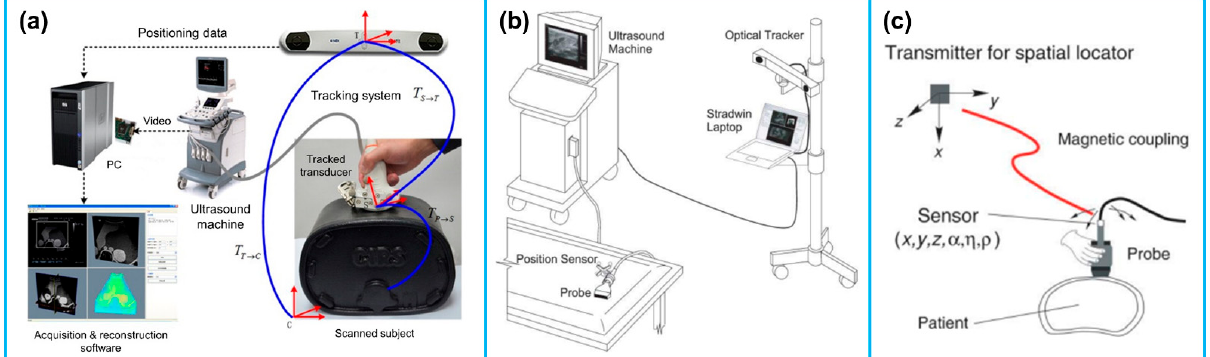
Figure 7. ( a ) The typical configuration of a freehand 3D US imaging system. Reprinted from [115] with permission. ( b ) An optical tracker based freehand 3D US imaging system. Reprinted from [109] with permission. ( c ) An electromagnetic sensor based freehand 3D US imaging system. Reprinted from [109] with permission.